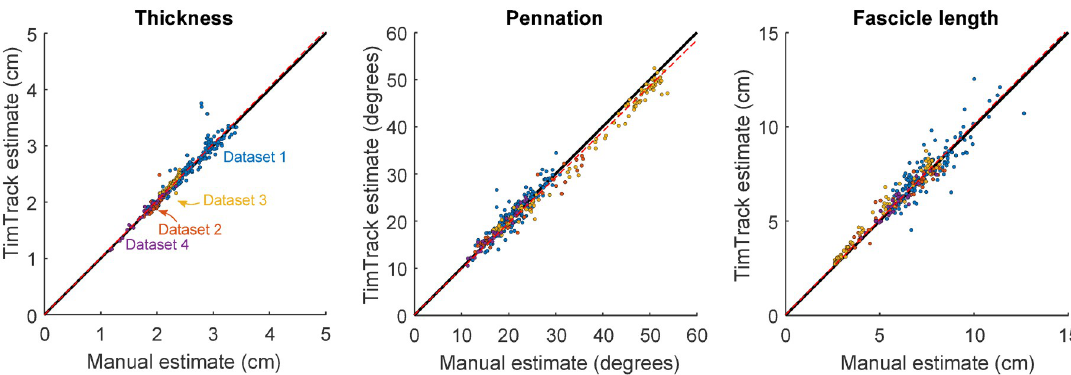
Fig 5. TimTrack algorithm estimates vs. mean manual observer estimates for all datasets. A. TimTrack algorithm estimates of muscle thickness increased linearly with mean of manual estimates (slope = 1.01 ± 0.01, linear regression, dashed red line). B. TimTrack algorithm estimates of pennation angle increased linearly with mean of manual estimates (slope = 0.97 ± 0.01, linear regression, dashed red line). C. TimTrack algorithm estimates of fascicle length increased linearly with mean of manual estimates (slope = 1.01 ± 0.01, linear regression, dashed red line). Overall, TimTrack’s were closely related to mean observer estimates (R 2 =